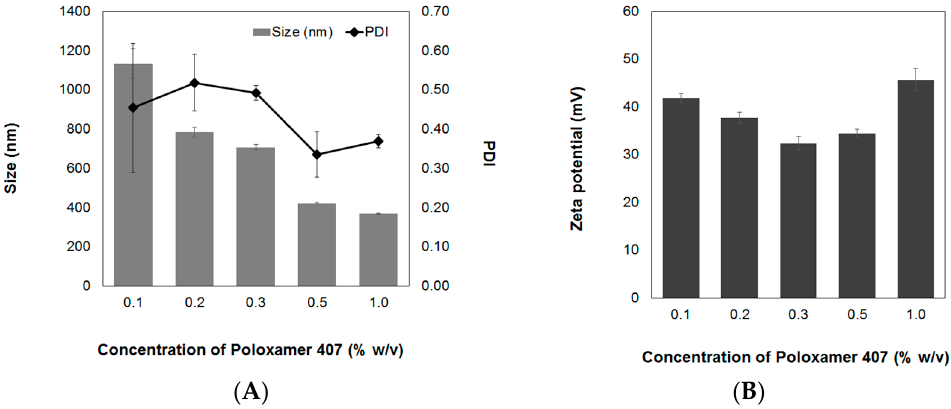
Figure 5. Effect of poloxamer 407 concentration on ( A ) size and PDI and ( B ) zeta-potential of sacha inchi oil loaded AL-CS nanoemulsion.